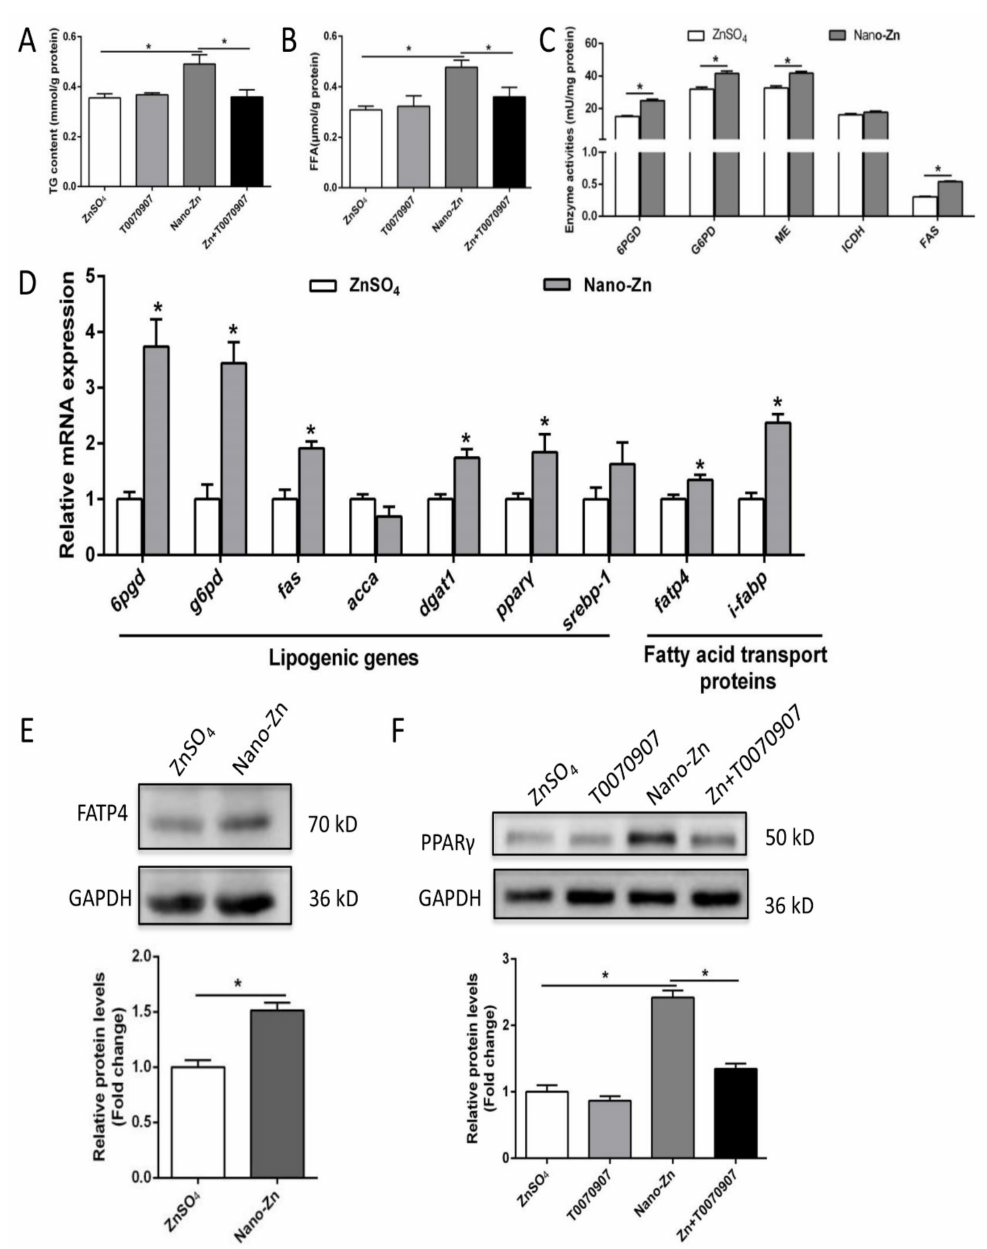
Figure 4. Nano-Zn induced TG accumulation by peroxisome proliferator-activated receptor gamma (PPAR γ ) pathway in intestinal epithelial cells. ( A ) TG content after 24 h treatments. ( B ) Free fatty acid content after 24 h treatments. ( C ) Enzyme activities. ( D ) The mRNA levels of lipogenic enzymes after ZnSO 4 or nano-Zn incubation for 24 h. ( E ) Protein levels of fatty acid transport protein 4 (FATP4) after 24 h of 40 µ M nano-Zn incubation. (F) Protein levels of PPAR γ of intestinal epithelial cells incubated for 24 h in control or 40 µ M nano-Zn containing medium with or without 2 µ M T0070907 pretreatment for 2 h. Values indicate means ± SEMs, n = 3–6. Asterisks ( ∗ ) indicate significant di ff erences between two groups ( p < 0.05, n =